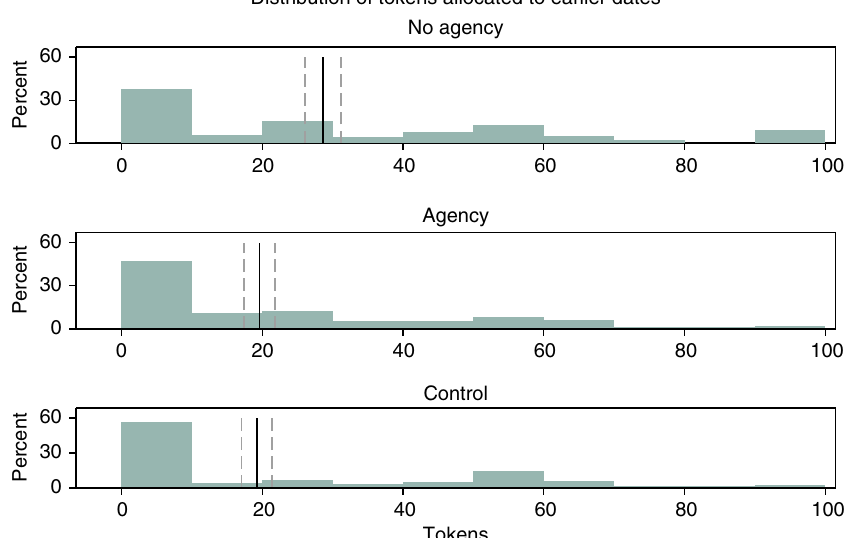
Fig. 2 Study 1 results: percent of tokens allocated to earlier dates, collapsing across allocation decisions. N = 211 participants. Black solid line denotes mean; gray dashed lines denote mean value ± 1